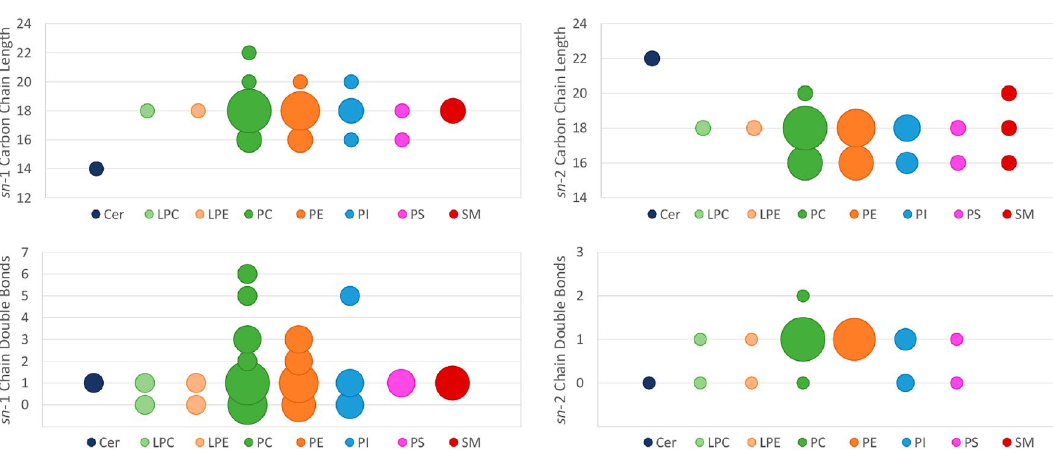
Figure 3. Acyl chain lenghts and unsaturation degree in each lipid class. Y-axis represents the characteristic analyzed and x-axis contains each lipid class with each corresponding color. Bubble sizes are proportional to the number of lipids at each data point. ( A ) Analysis of the sn-1 carbon chain length in each lipid class. The most common length was of 18 carbon for most lipid classes. ( B ) Analysis of the sn-2 carbon chain length in each lipid class. The most common lengths were of 18 and 16 carbon for most lipid classes. ( C ) Analysis of the sn-1 chain double bonds, regardless of the chain length. Most lipid classes had either 0 or 1 double bond in sn-1. ( D ) Analysis of the sn-2 chain double bonds, regardless of the chain length. Most lipid classes had 1 double bond in